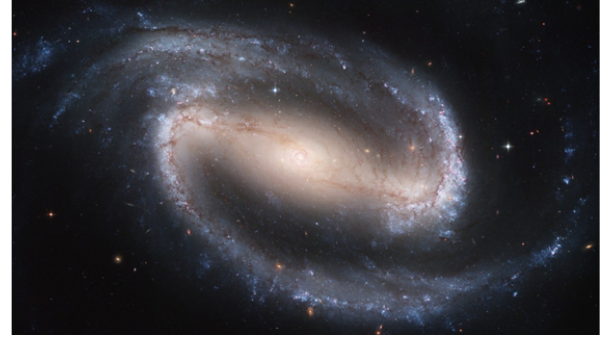
Figure 14. Hubble Space Telescope image of barred spiral galaxy, NGC